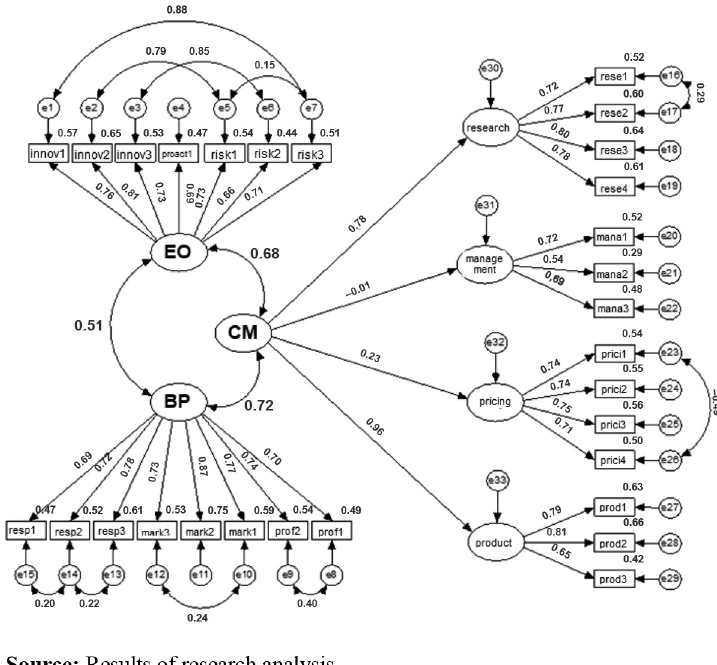
Figure 2. Diagram for the measurement